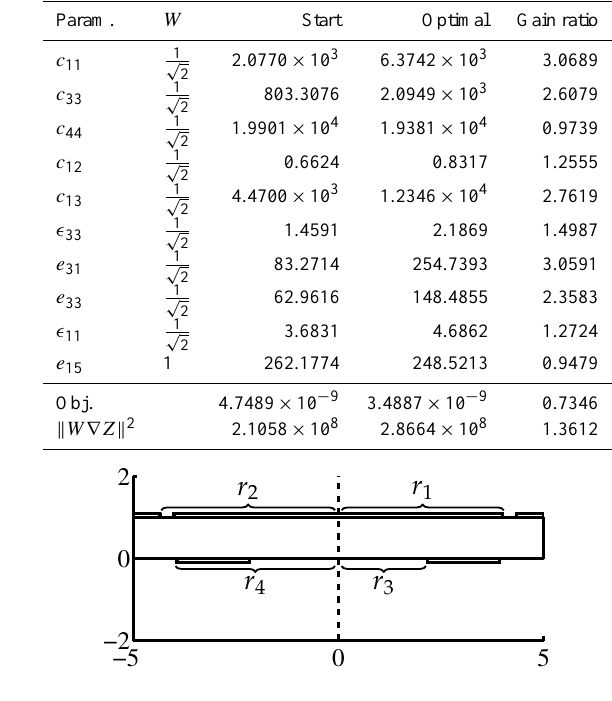
Table 3. Mixed weights: Improvement of sensitivity of impedance w.r.t. material parameters using W = 1 diag (1 ,..., 1 , √ 2) : With exception of c 44 and e 15 all partial sensitivities are increased. Objective √ 2 ·